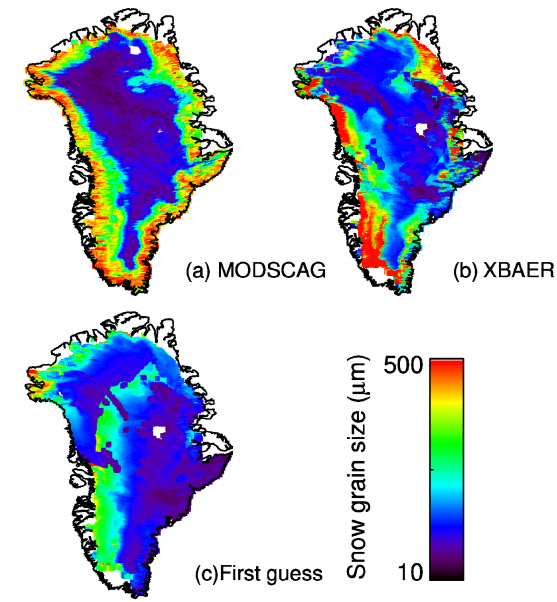
Figure 4. A comparison of the MODSCAG SGS (a) , XBAER- derived SGS (b) and first guess (c) over Greenland on 28 July 2017.